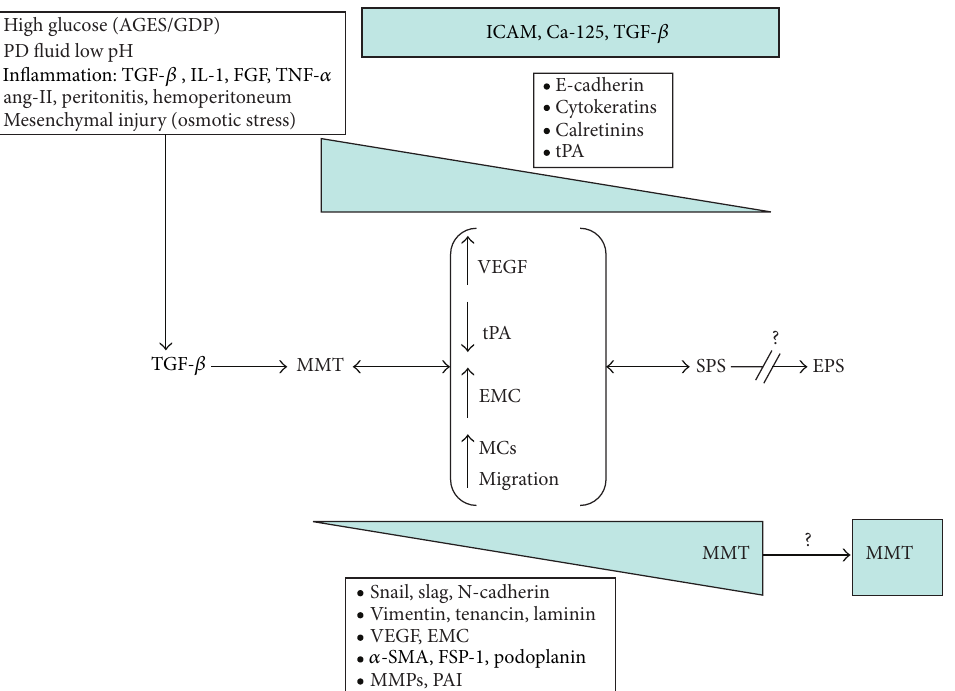
Figure 1: Mechanism for MMT, SPS, and EPS induction as a single process. The PD fluids bioincompatibility induces overproduction of TGF- 𝛽 that initiates and perpetuates the MMT. MMT includes angiogenesis (VEGF), decreased in fibrinolytic capacity by decrease in tPA, increased in extracellular matrix component production (collagen-1, fibronectin, etc.), and migration mediated by MMPs. MCs lost their gene expression of E-cadherin, cytokeratins, and other and gain the expression of snail, slag, N-cadherin, and so forth. All of these changes become to peritoneal fibrosis and sclerotic peritoneal syndromes (SPS) which are originally reversible. MMT increases in parallel to fibrosis but its role in EPS pathogenesis is unknown. EPS is considered as irreversible process. ICAM, TGF- 𝛽 , and Ca-125 expression remains